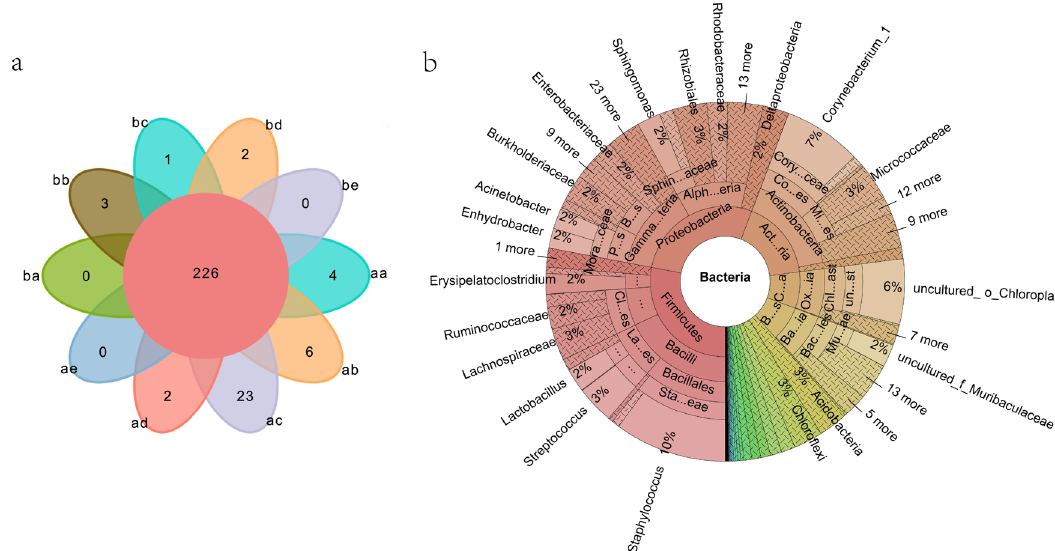
Figure 3. Venn distribution of a genus-level for all sample taxa. b KRONA species annotation map of all samples: RG/aa (carpet), ab (barre), ac (hoop), ad (ball), ae (palm); AG/ba (carpet), bb (wall bars), bc (horizontal bar), bd (parallel bars), be (palm).